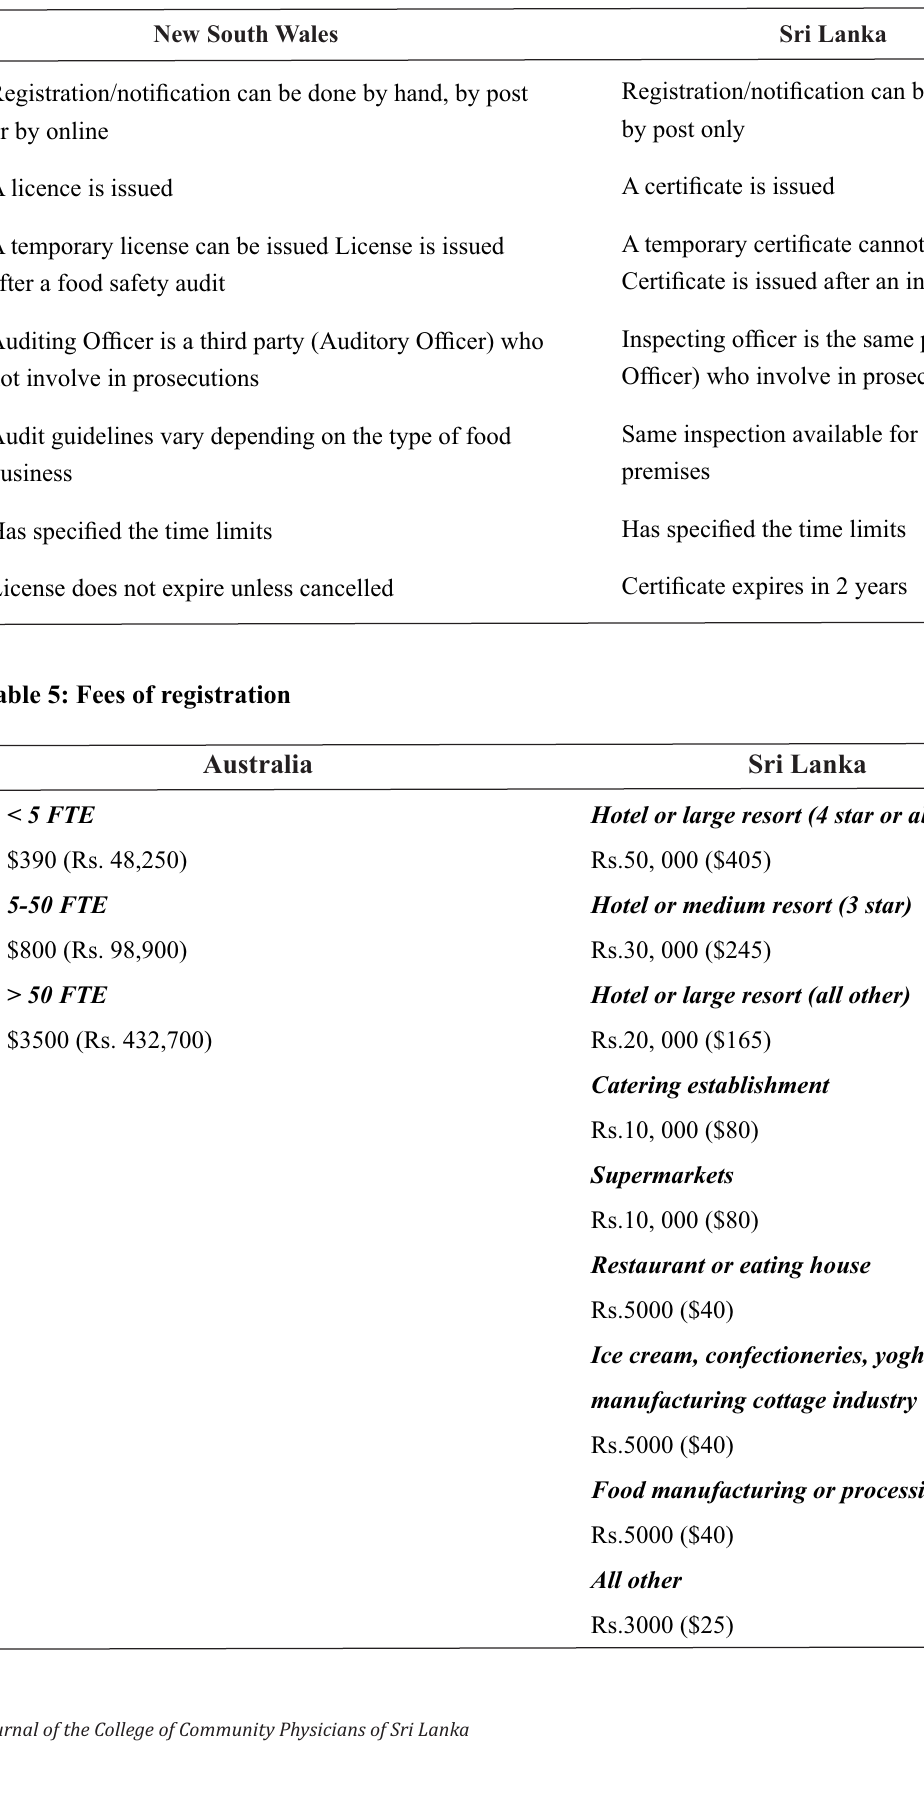
Table 4: Process of registration